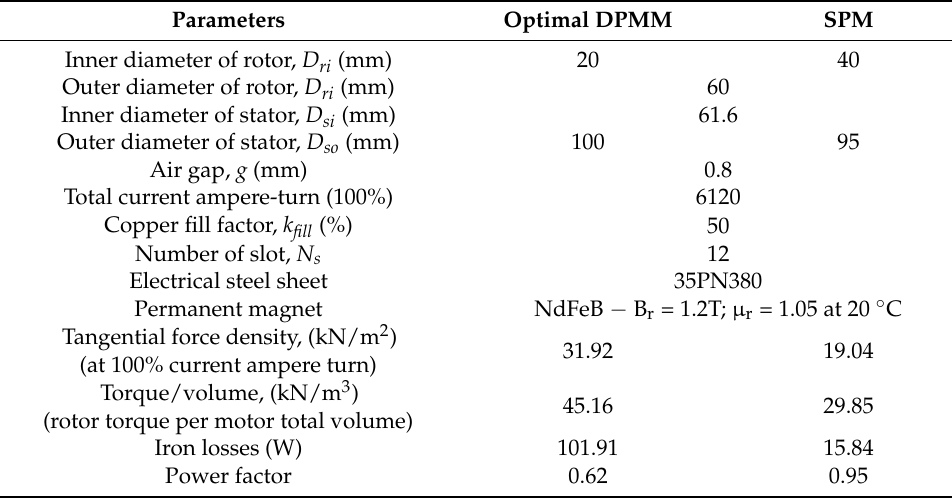
Figure 10. Flux distribution on the DPMM. Table 4. Characteristics of the two studied models.